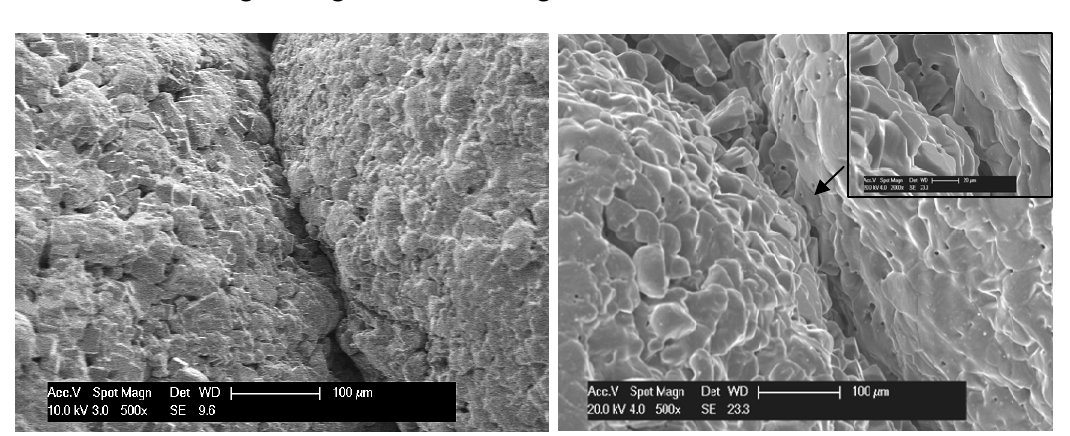
Figure 3. Connections between beads in preforms compacted at a pressure of 39 MPa: Left, without sintering and right, after sintering at 730 °C for 4